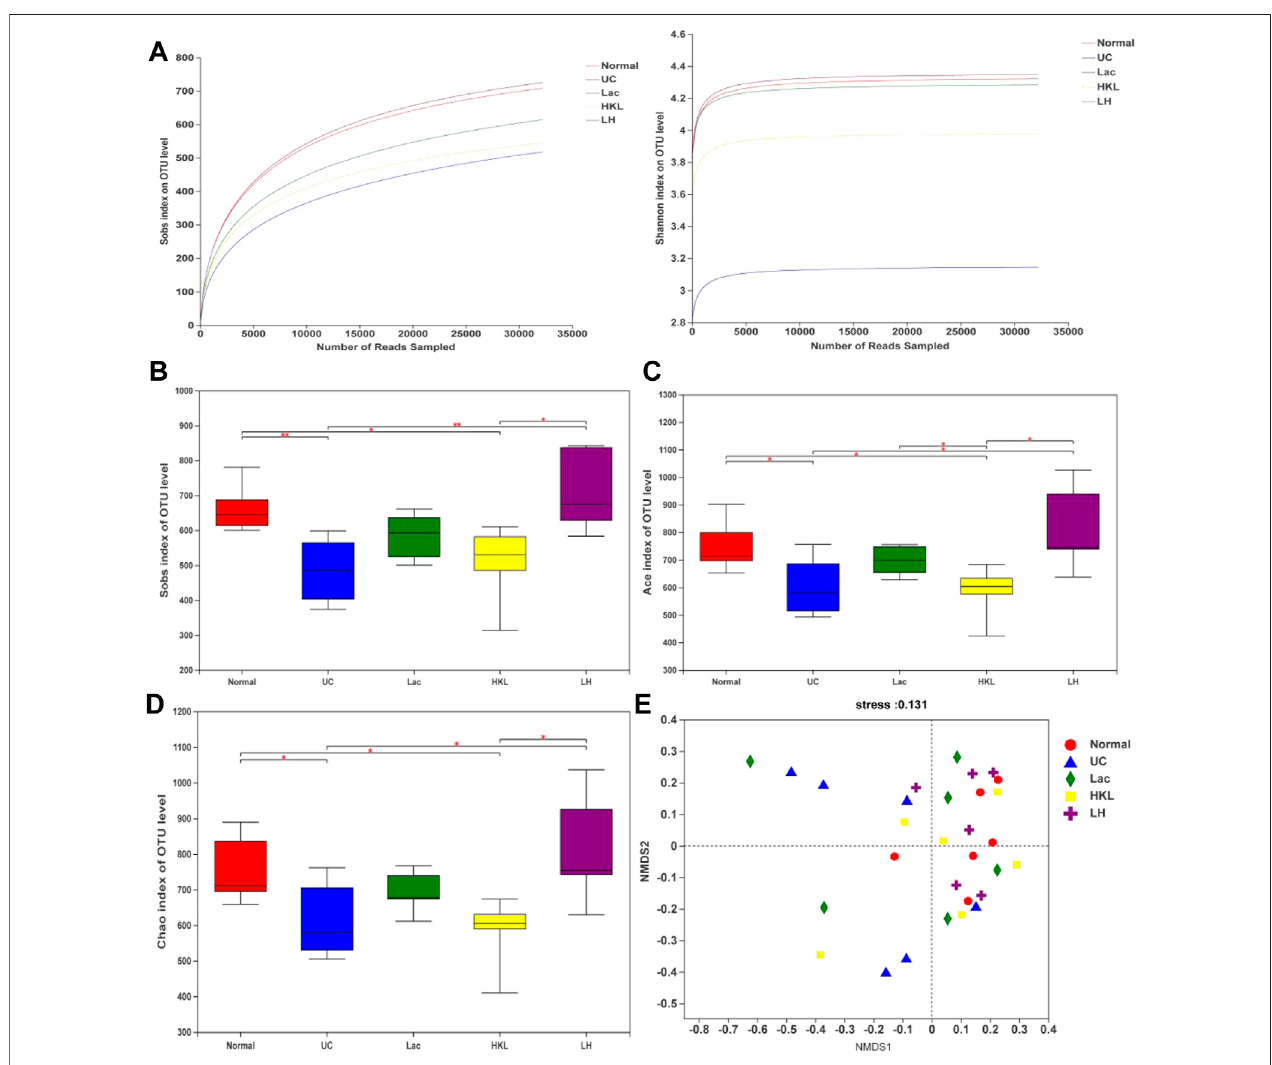
FIGURE3| Gutmicrobiotadiversityanalysis( n =5~6). (A) SobsandShannonrarefactioncurveofsamples. (B) α -DiversityevaluatedbySobsindex. (C) α -Diversity evaluated by Ace index. (D) α -Diversity evaluated by Chao index. * p < 0.05, ** p < 0.01. (E) NMDS analysis.